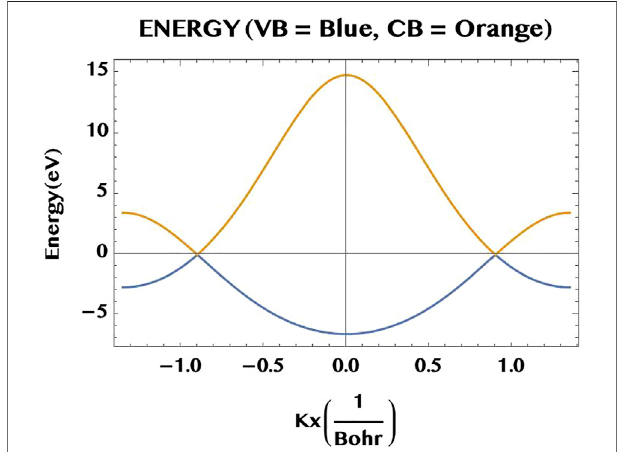
FIGURE2| A1Dcutofthebandstructureofgraphene monolayer along the k x -axis, with k y =0. The lower lying valence band (VB, blue) and the upper lying conduction band (CB, orange) are degenerate at the two Dirac points (cid:1) ± 0 . 9 [ 1 ] ,1 Bohr =0.0529 nm).Notethatfor (alongthe k x -axisat± 4 π 3 a Bohr a non-vanishing overlap integral s 0 = 0.129, the bands are linear and symmetric near the Dirac point (but differ away from